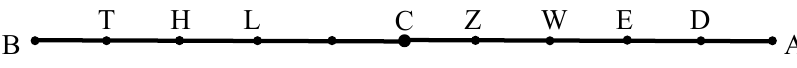
Figure 7. The force of weight. Redrawn from [19], p.